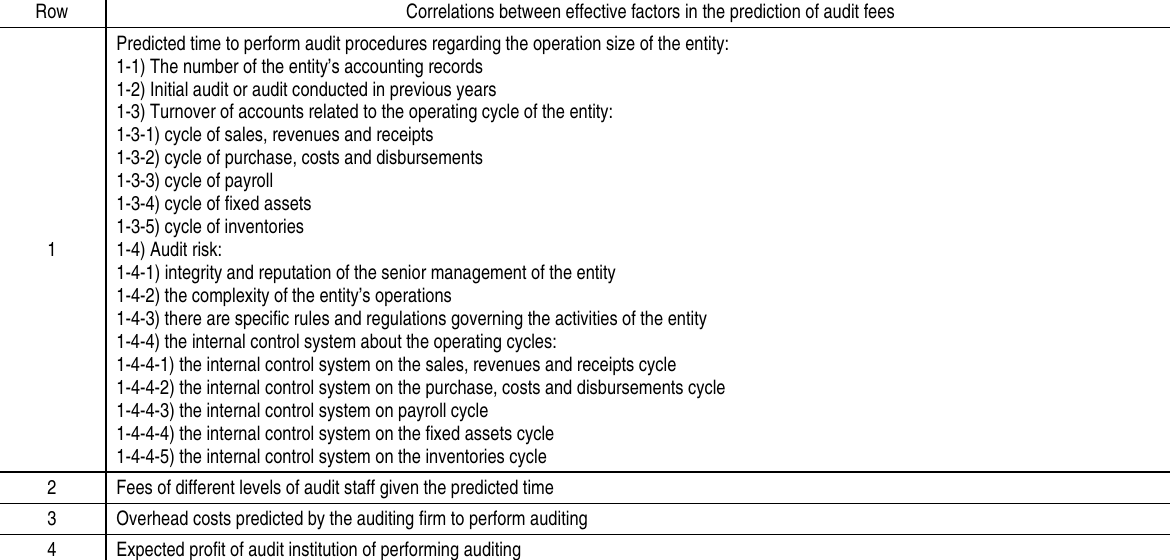
Table 4. Correlations between factors affecting the prediction of audit fees